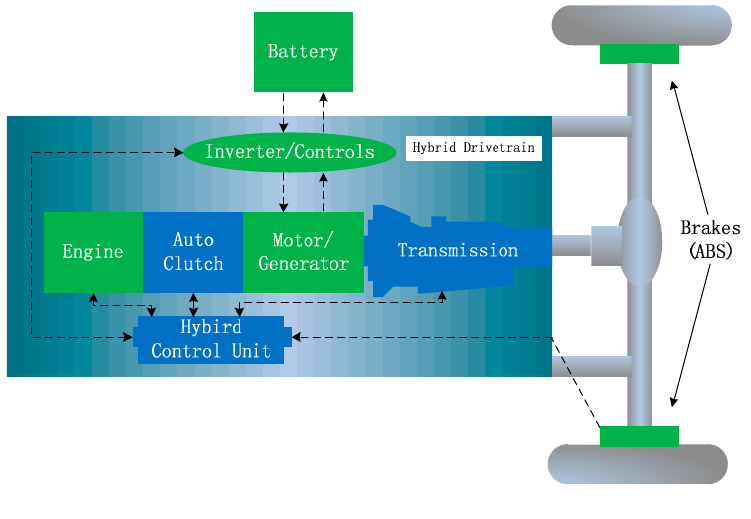
Figure 2. Drivetrain structure of the HEV. Table 1. Summary of the HEV parameters.